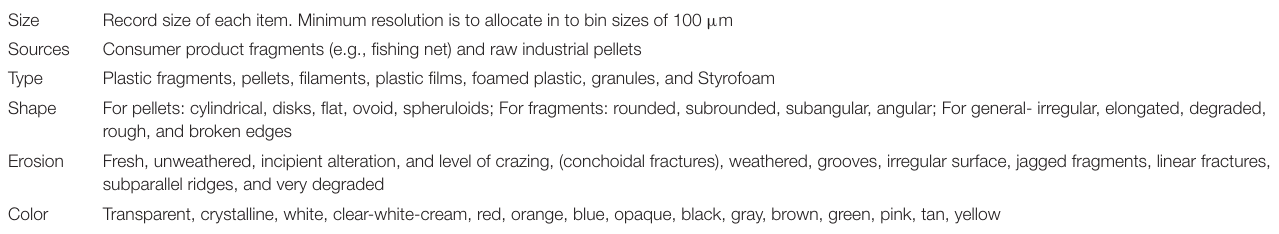
TABLE 1 | Categories used to describe microplastic appearance in the